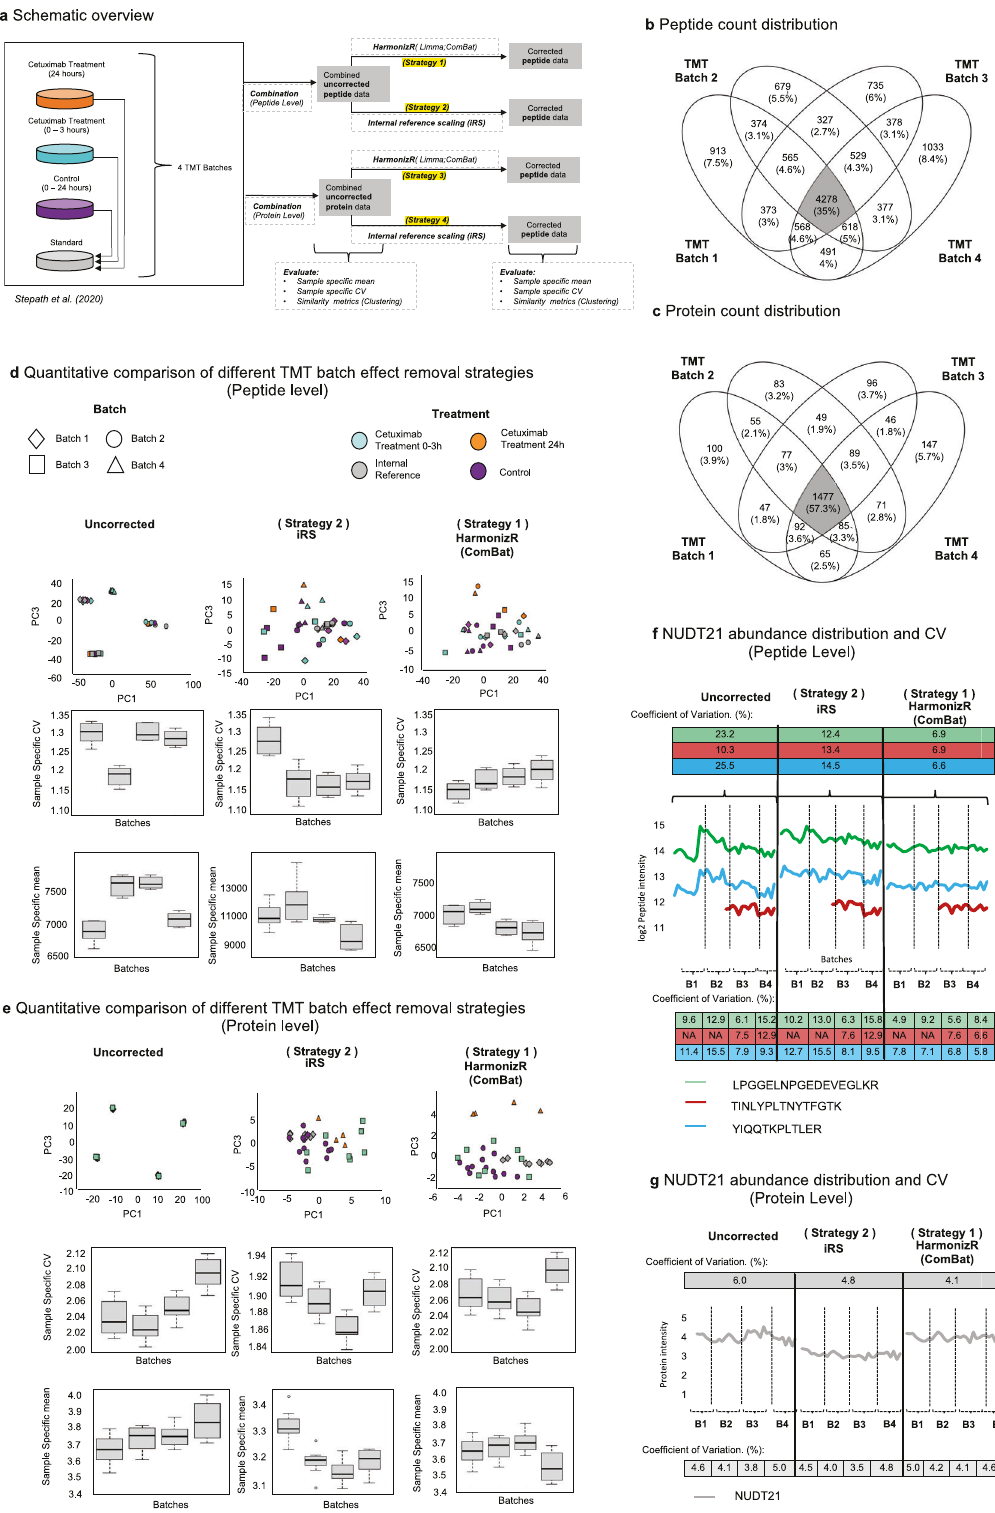
in ATRT and medulloblastoma. These results go in line with the fi ndings, proposed by Petralia et al. 23 (Fig. 6e). Matrix dissection of 23 batches may potentially result in 4194281 combinations of submatrices for batch correction (see equation above), however, 3654 submatrices occurred in the experiment. The measured speedup is shown for both the entire HarmonizR execution (with visualization of Amdahl ’ s law 24 ) and